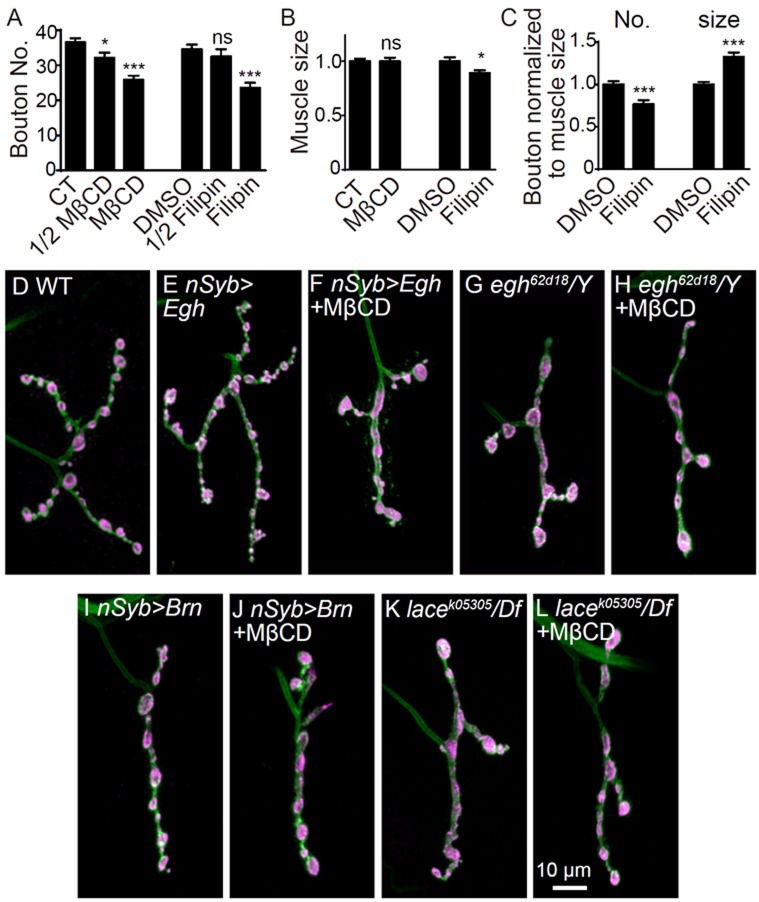
Additional NMJ images and quantifications of bouton number and bouton size.(A) Quantification of bouton number of NMJ4 from wild-type larvae fed with 0 mM (CT), 10 mM, 20 mM MβCD and 0 μg/ml (DMSO vehicle only), 25 μg/ml, 50 μg/ml filipin III. (B and C) Quantifications of muscle four surface area (B), relative bouton number and size normalized to muscle surface area (C) upon indicated treatments. n ≥ 8 larvae; ns, no significance, *p<0.05, ***p<0.001 by one-way ANOVA with Tukey post hoc tests; error bars: s.e.m. (D–L) Images of NMJ4 co-labeled for anti-HRP (green) and anti-CSP (magenta) in untreated wild type (D), UAS-Egh/+; nSyb-Gal4/+ (E), UAS-Egh/+; nSyb-Gal4/+treated with 20 mM MβCD (F), egh62d18/Y (G), MβCD treated egh62d18/Y (H), nSyb-Gal4/UAS-brn (I), MβCD treated nSyb-Gal4/UAS-brn (J), lacek05305/Df(2L)Exel7063 (K), and MβCD treated lacek05305/Df(2L)Exel7063 (L). Scale bar: 10 μm.